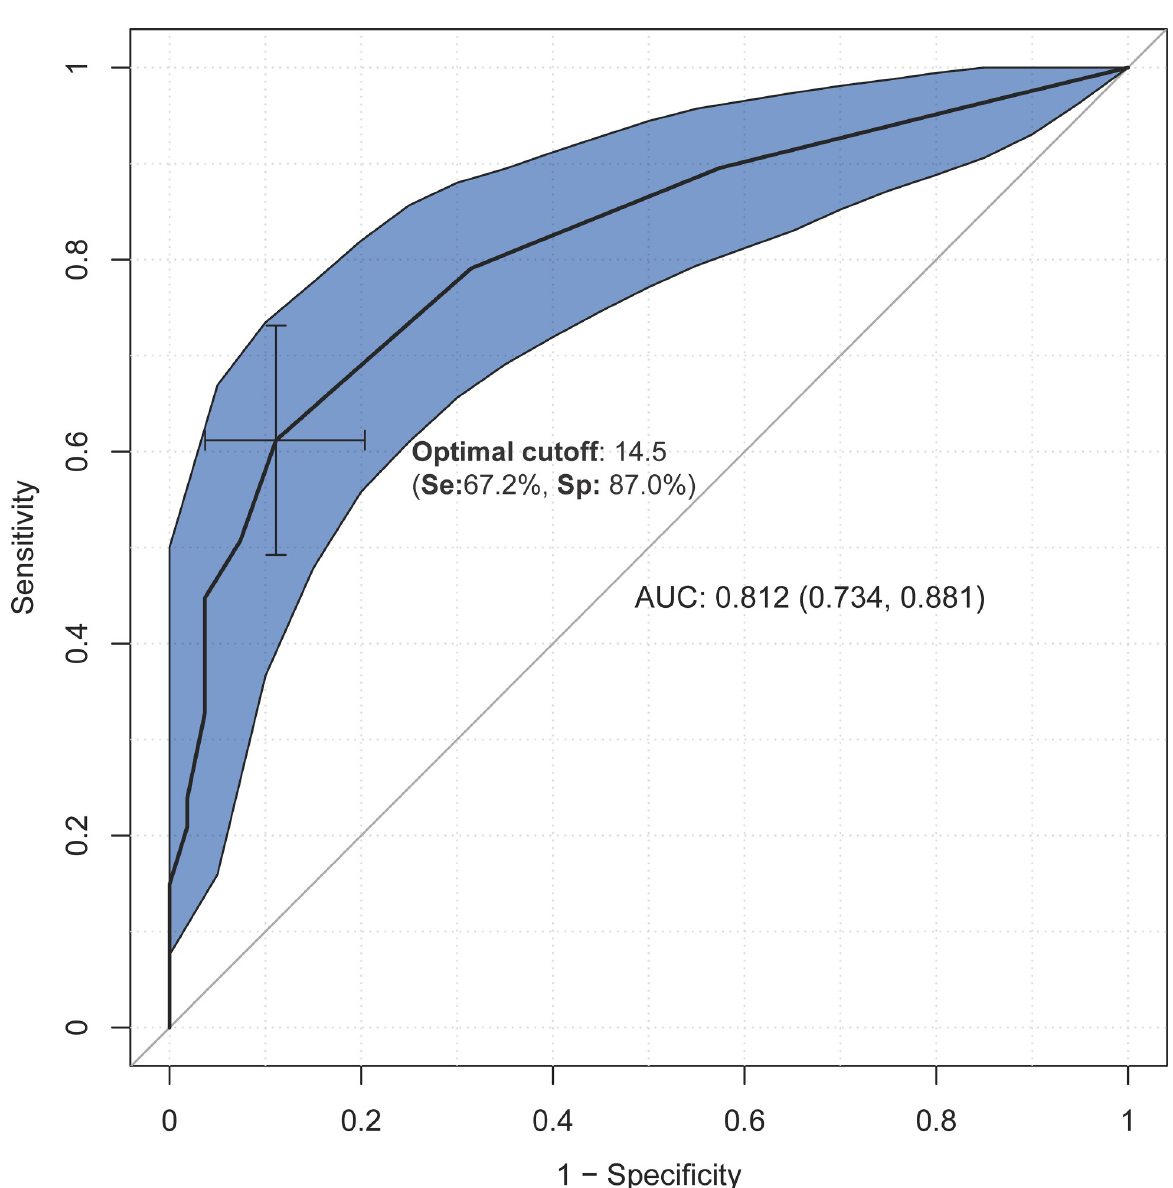
Fig 1. Discriminant power of the FAB-E among healthy subjects and Parkinson’s disease patients. Abbreviations: Se, sensitivity; Sp, specificity; AUC, area under the curve.